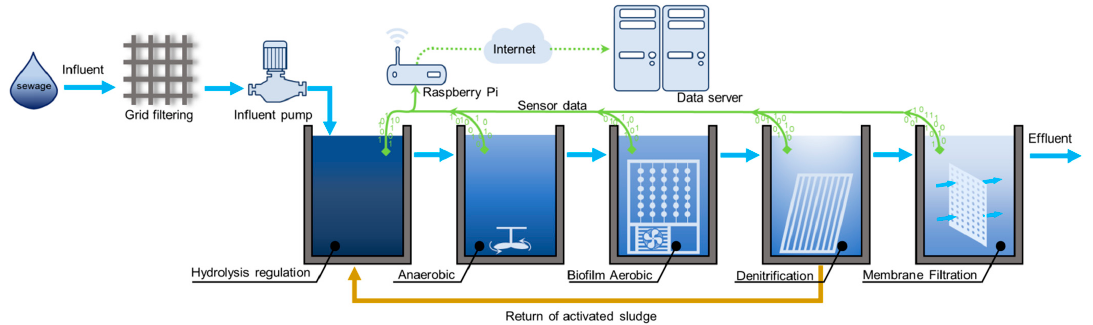
Figure 1. Schematic diagram of the wastewater treatment system based on dual-mode dynamic sep- aration.